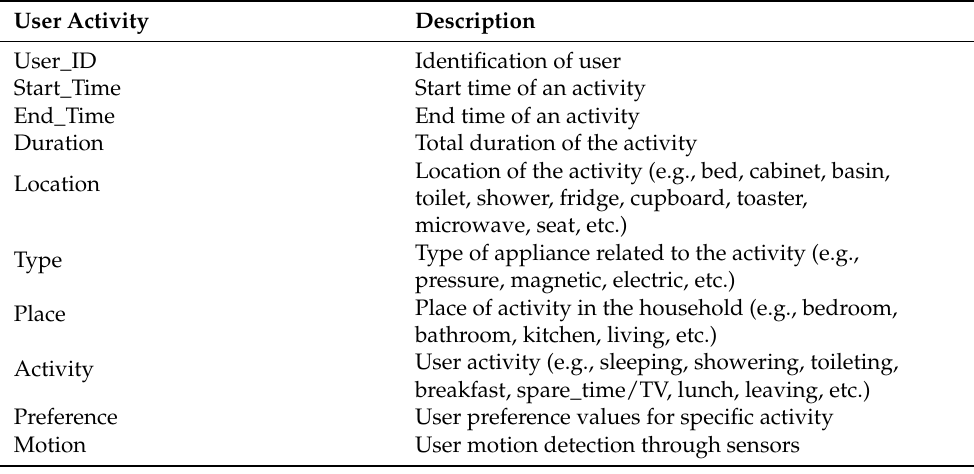
Table 1. User activity sensor data feature